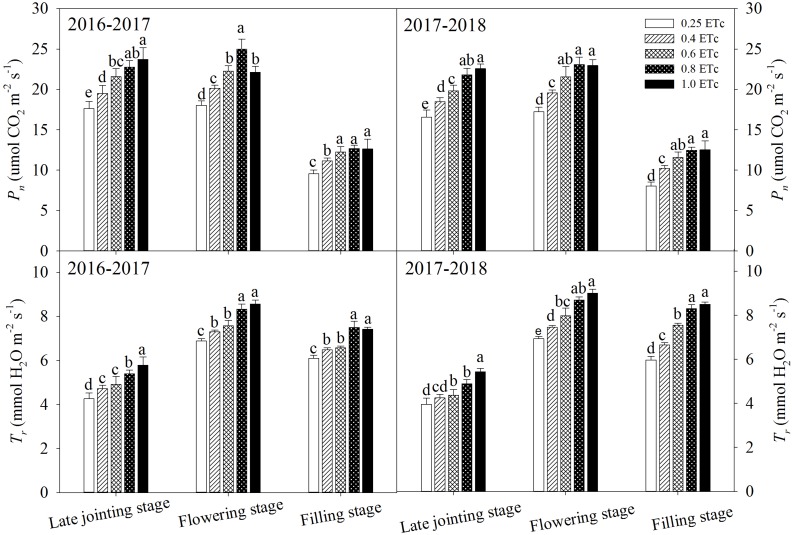
The photosynthetic rate (Pn) and transpiration rate (Tr) of winter wheat under different treatments. Vertical bars represent standard errors (n = 4). Different lowercase letters above the bars in the same growing stage are significantly different among different treatments at P < 0.05. The 0.25, 0.4, 0.6, 0.8, and 1.0 ETc represents 25, 40, 60, 80, and 100% crop evapotranspiration, respectively.